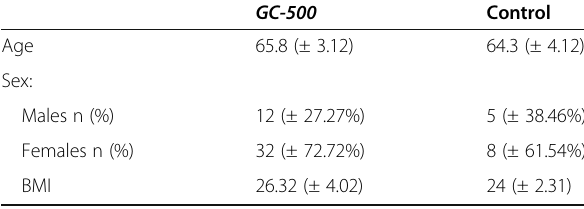
Table 1 Demographics of subjects in this study GC-500 Control